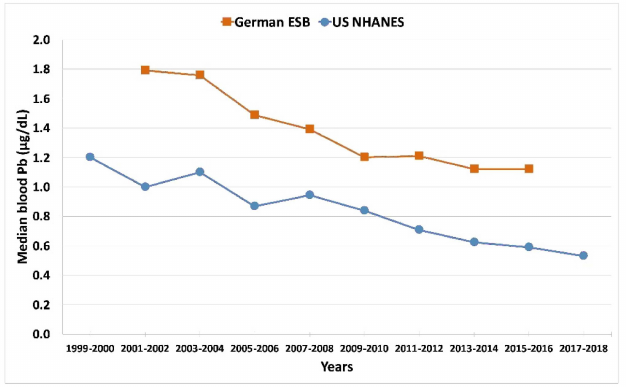
Figure 4. Blood Pb data for 20–29-year-old urban German population compared to the US NHANES (nationally represented data) for the same age group. Compiled from Table 3 in ref. [17] and from NHANES data [18]. The graph was created using Microsoft Excel Version 16.54 (Redmond, WA,